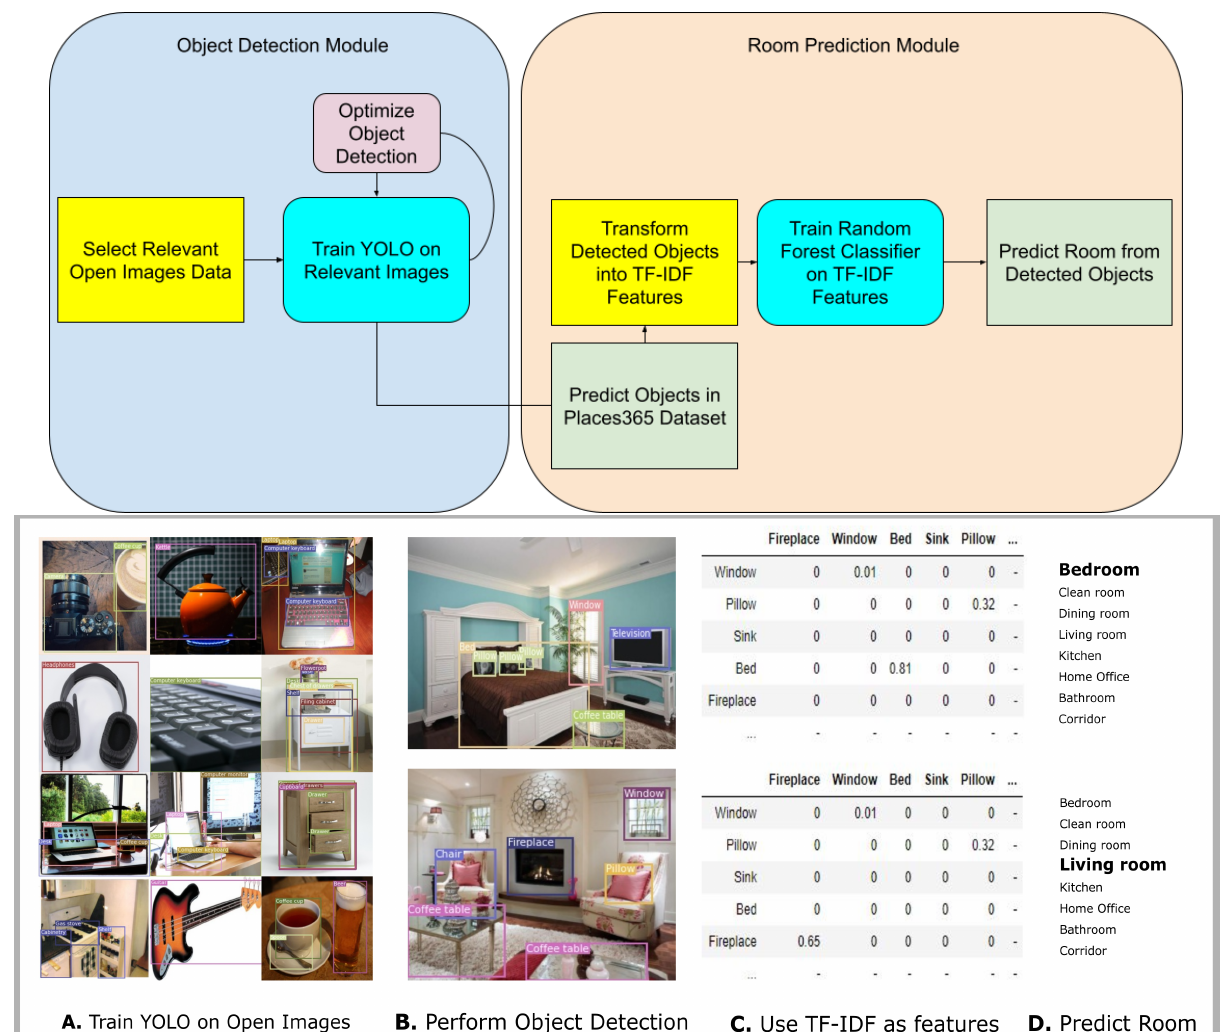
Figure 1. Visualization of the pipeline. top : general diagram of the modules for object detection and room prediction, and bottom : step-by-step scheme ( A ) Train YOLO to detect indoor objects. ( B ) Perform object detection on scene data (examples use IOD155 with conf. thresh = 0.25). The images are from the ADE20k dataset ( C ) Transform predicted object labels into TF-IDF input features. ( D ) Train classifier to predict room category based on these input